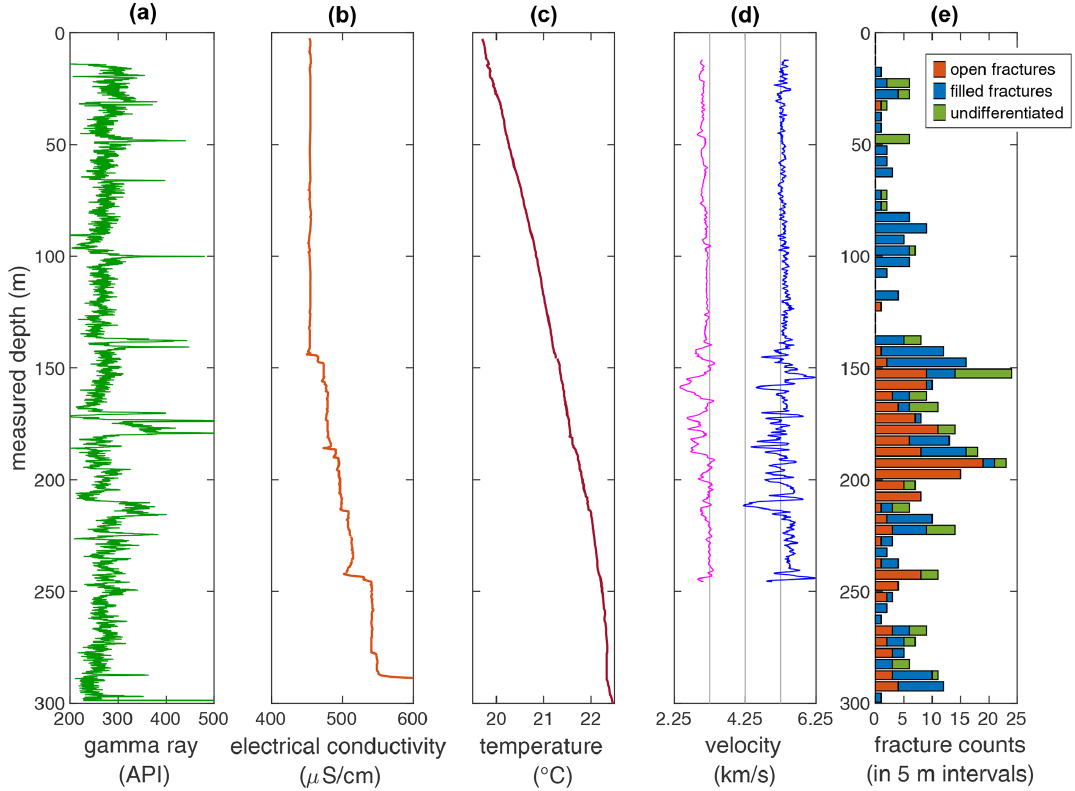
Figure 4. Integrated geophysical logs of borehole CB1: (a) gamma ray; (b) electrical conductivity; (c) temperature; (d) sonic compressional and shear wave velocities ( V p and V s ); (e) density of mapped fractures from televiewer